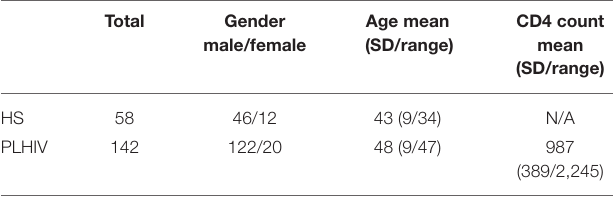
TABLE 1 | Demographic information of the study